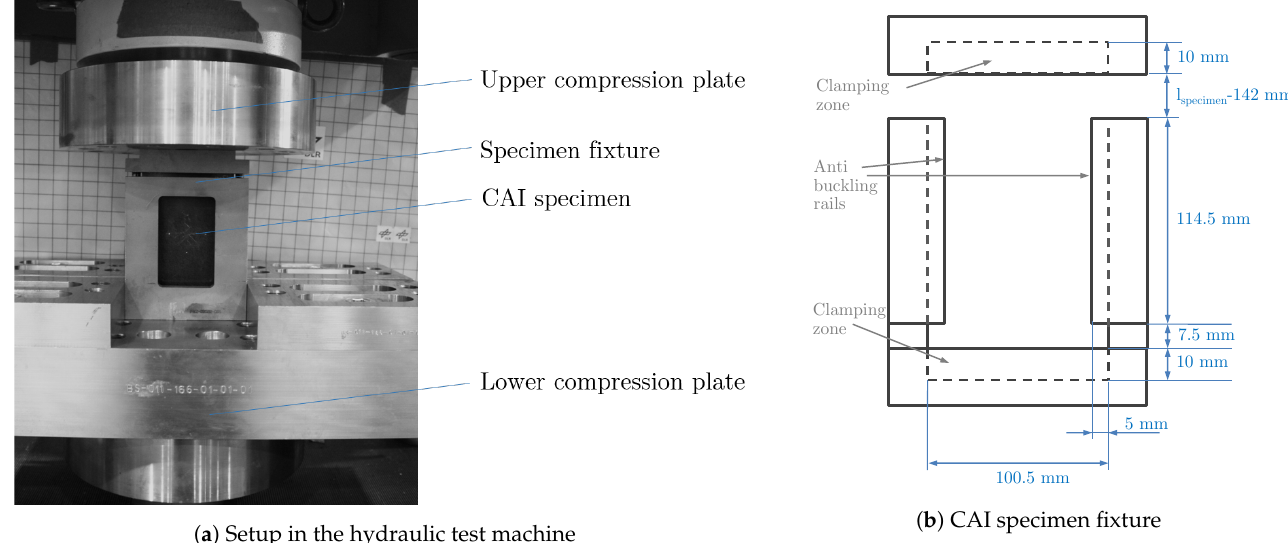
Figure 4. Test setup ( a ) and a sketch of the fixture ( b ) for the compression after impact